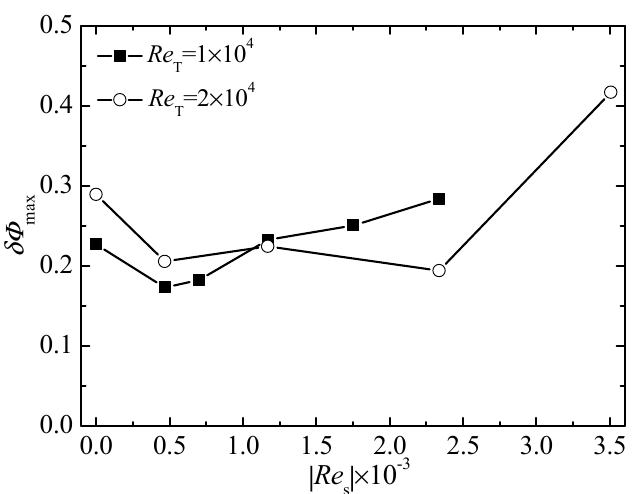
Figure 6. The time dependencies of azimuthal velocity V at the monitoring point P ( R = 0.75, Z = 0.5, θ = 0) when Re c = 0 and Re T = 10 4 . ( a ) Re s = − 1.8 × 10 3 ; ( b ) Re s = − 2.3 × 10 3 .